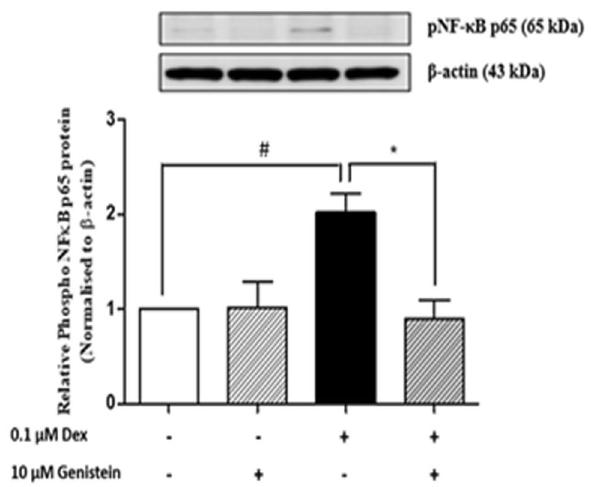
Figure 5. Effect of genistein on dexamethasone-induced NF-κB activation. INS-1 cells were treated with 0.1 μM dexamethasone with or without 10 μM genistein of 48 h. A representative Western blot analysis of phosphorylated NF-κB p65 protein normalized to β-actin protein in INS-1 cells. All bands were cropped and full-length blots are shown in supplementary Fig. 10. Data are expressed as mean ± SEM of 3 independent experiments. #, P < 0.05 versus control; *, P < 0.05 versus 0.1 μM